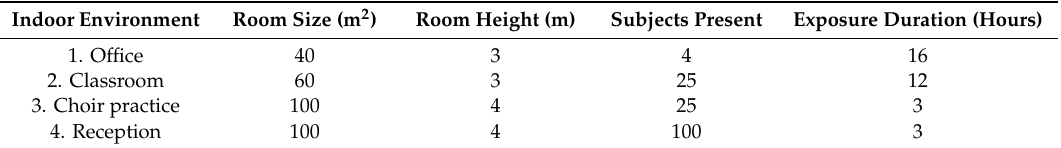
Table 2. Example indoor environments with one index subject present.